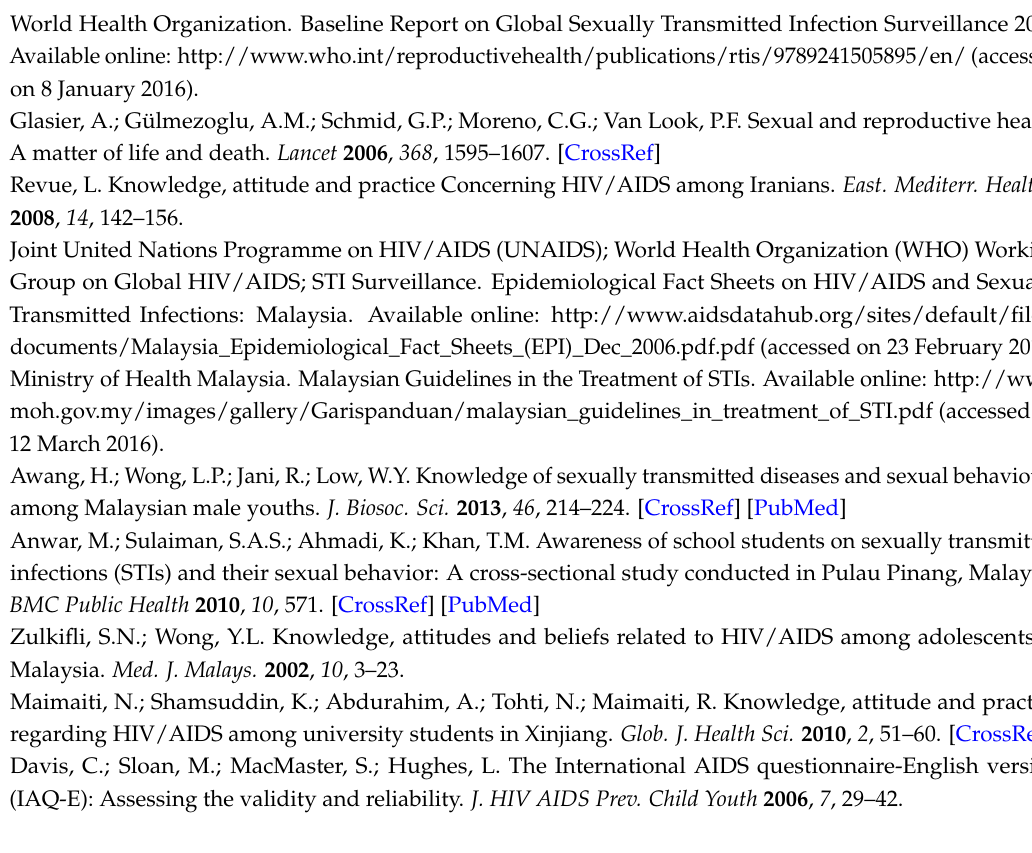
Table S1: Socio-demographic characteristics of the health and non-health university students in this study; Table S2: Sources from which the university students obtained their STD information; Table S3: Multiple logistic regression predicting university students’ knowledge level on STDs; Table S4: Association between preventive practices level and socio-demographic characteristics and knowledge level of the students related to